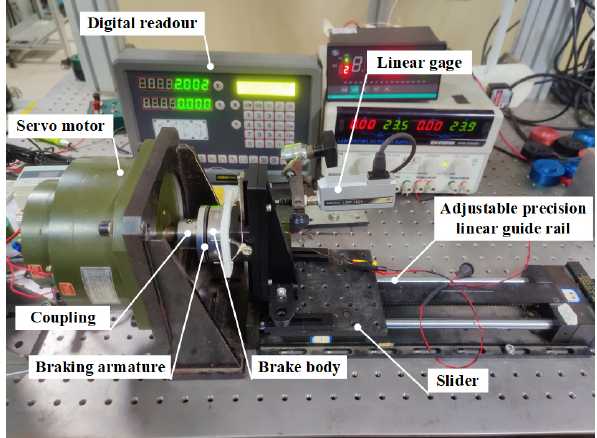
Figure 17. Experimental device for braking torque